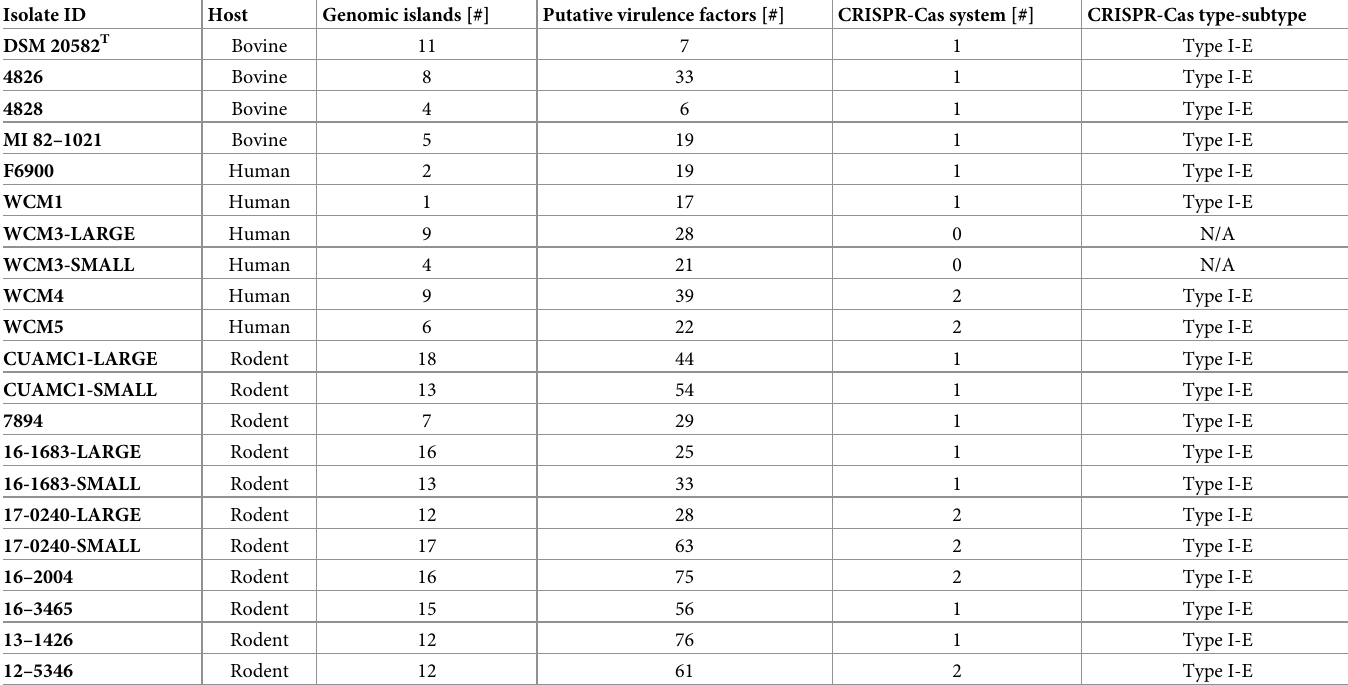
Table 3. Number of genomic islands, putative virulence factors, and CRISPR-Cas systems in 21 C . bovis isolates.